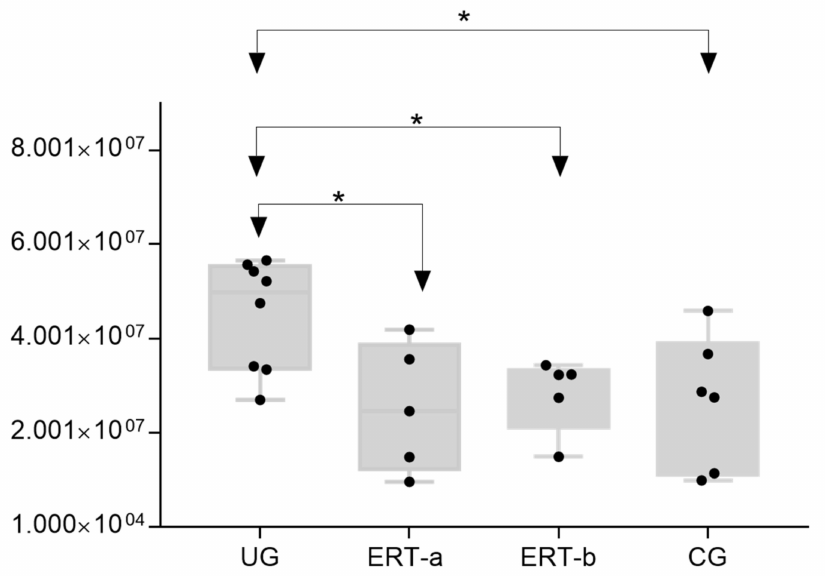
Figure 13. Box plot depicting ATA1 levels in each of the study groups. Each data point represents the median value obtained in an individual sample. The line inside the box represents the median of all values obtained. The upper and lower limits of the box represent the first and third quartiles. Whiskers represent the minimum and maximum values within 1.5 times the interquartile range. Any data points not included between the whiskers are considered outliers. * p <